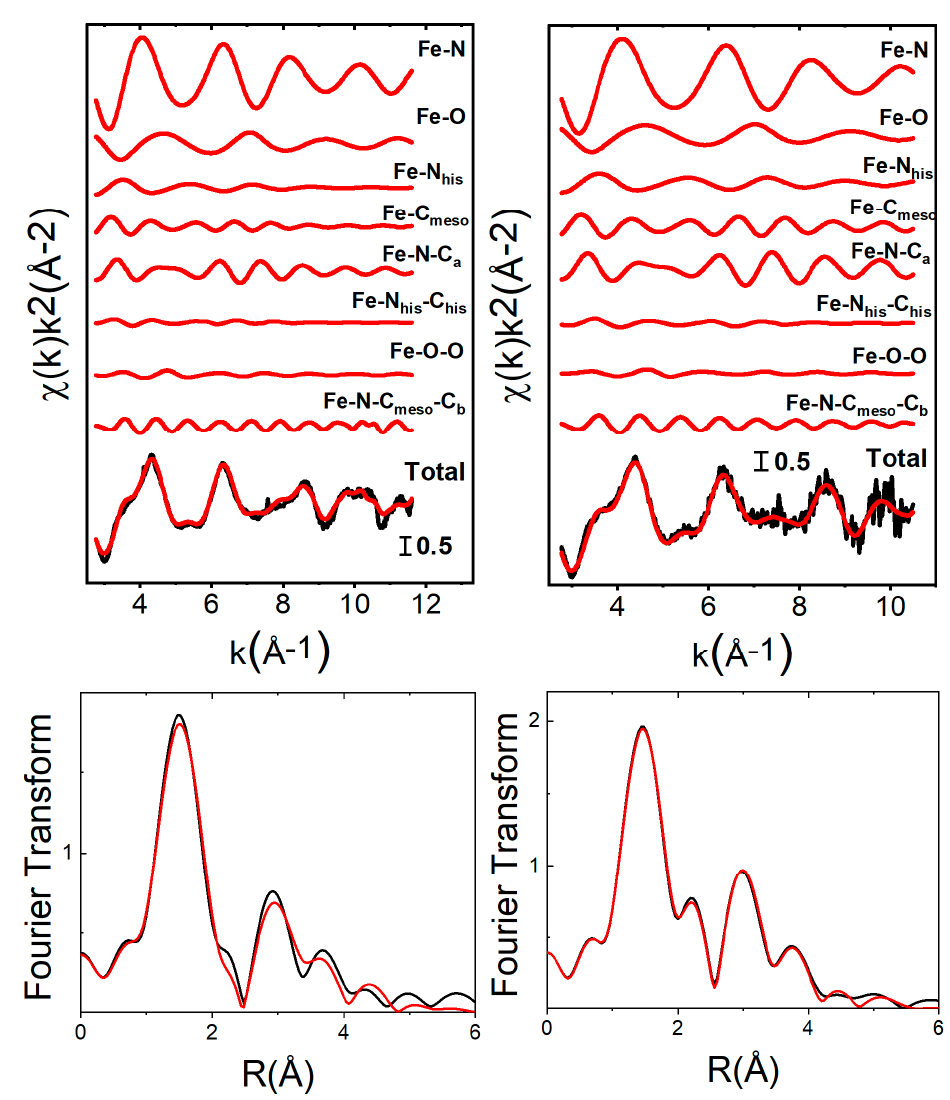
Figure 3. Fe K-edge EXAFS analysis of the free and adsorbed oxyHb. Left panel, free oxyHb: from top to bottom two-, three-, and four-body contributions included in the fit (red curves), the total theoretical signal (red curve) superimposed to the experimental one (black curve), and the fit in the Fourier transformed space. Right panel, the same analysis for adsorbed